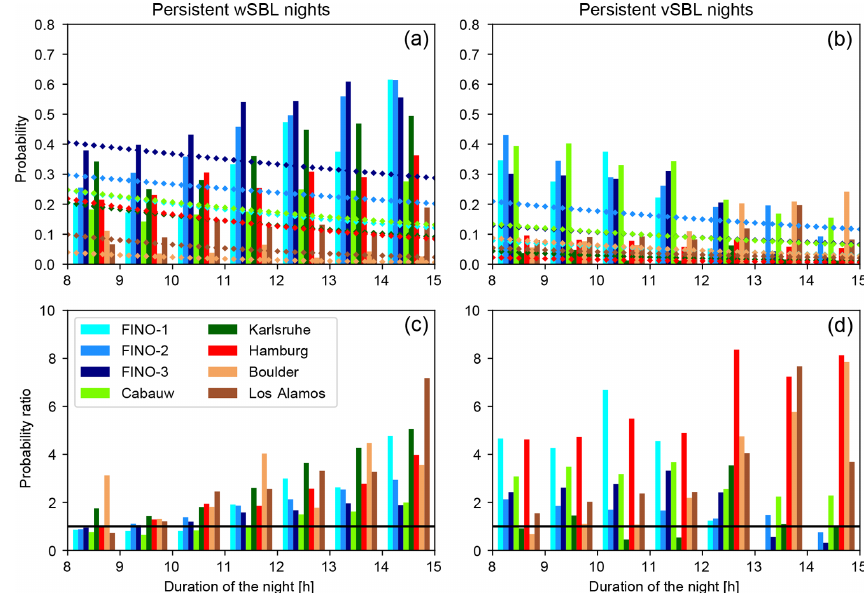
Figure 1. Occurrence probabilities of very persistent wSBL ( a , bars) and vSBL ( b , bars) nights as estimated from VP ref for nights of different lengths (in 1h increments) at the different tower sites, compared to the occurrence probabilities of very persistent nights computed from the FSMC using Q ref (diamonds). Lower panels show the ratio of the probabilities in the upper panels (values from the VP ref divided by those from the FSMC).